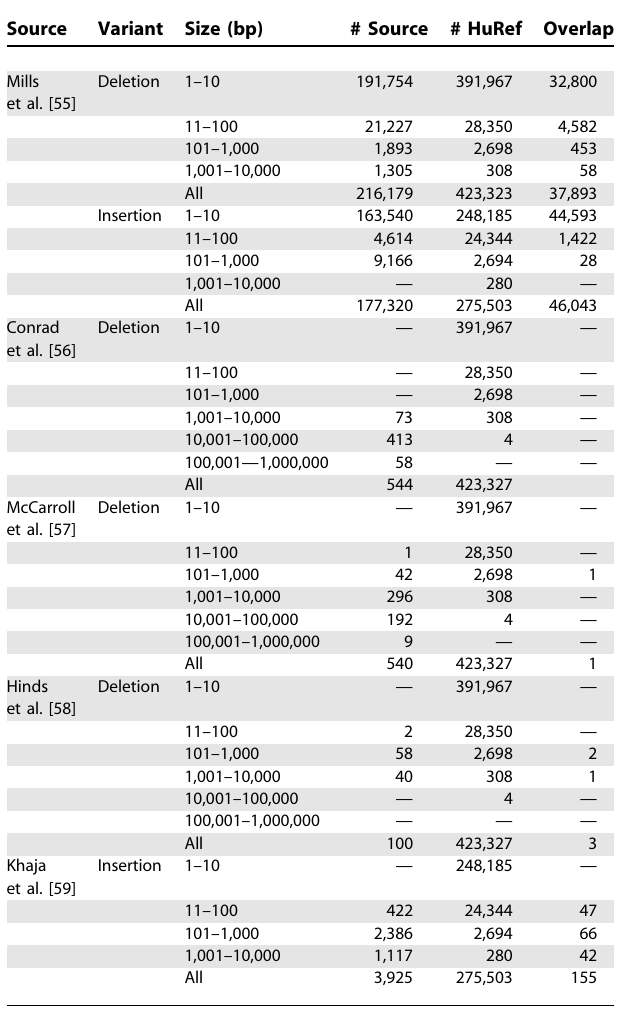
Table 11. Comparison of HuRef Homozygous Indels to Indel Variants Identified from Other Studies Source Variant Size